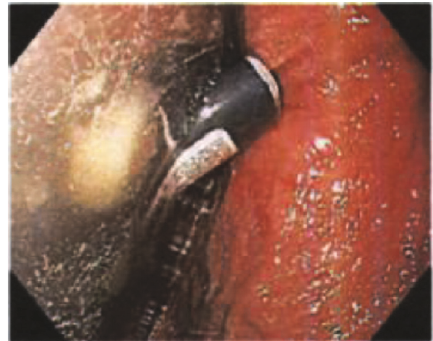
Figure 3: Gastric ulcer secondary to cigarette lighter